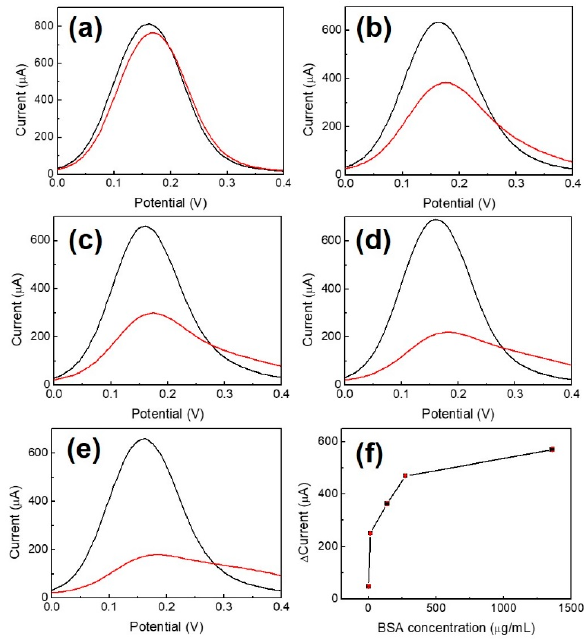
Figure 5. DPV measurement with BSA of different concentrations used as a blocking buffer ( a ) 1.36 μ g/mL, ( b ) 13.6 μ g/mL, ( c ) 136 μ g/mL, ( d ) 272 μ g/mL, ( e ) 1360 μ g/mL, and ( f ) current change versus concentration of BSA (n-3). The black and red curves illustrate the results of Au/NiPc and Au/NiPc/BSA electrode measurements, respectively.